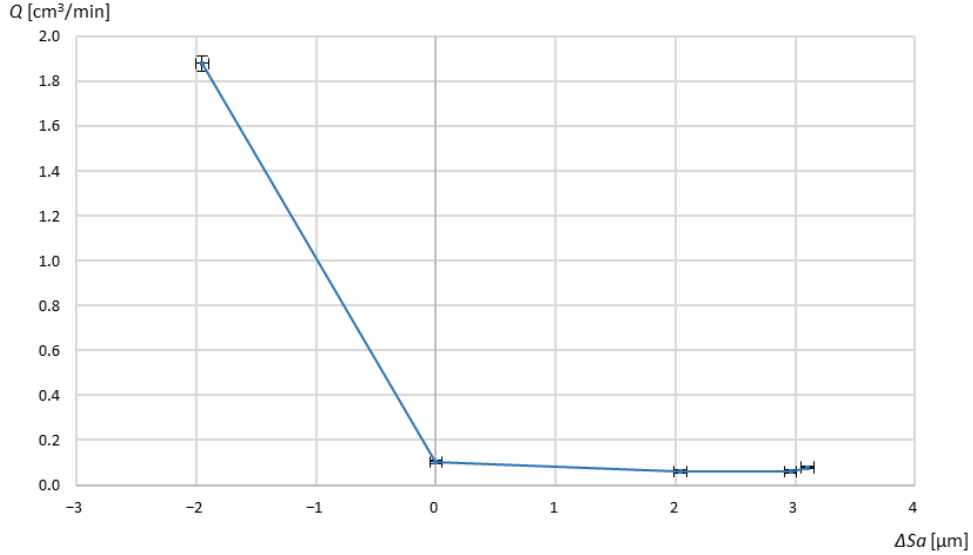
Figure 13. The value of leakage Q as a function of the difference in the value of the surface topography parameter Sa for a constant compressive force of 2280 N for the base surface with the value Sa = 3.29 µm.